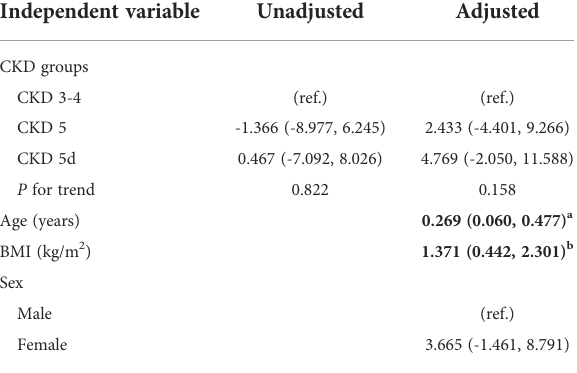
TABLE 5 Association of R2* (s -1 ) with CKD groups and iPTH in the adjusted